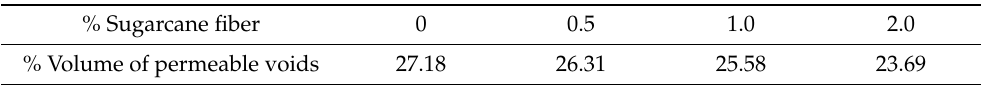
Table 3. Percentage of volume of permeable voids as a function of sugarcane fiber